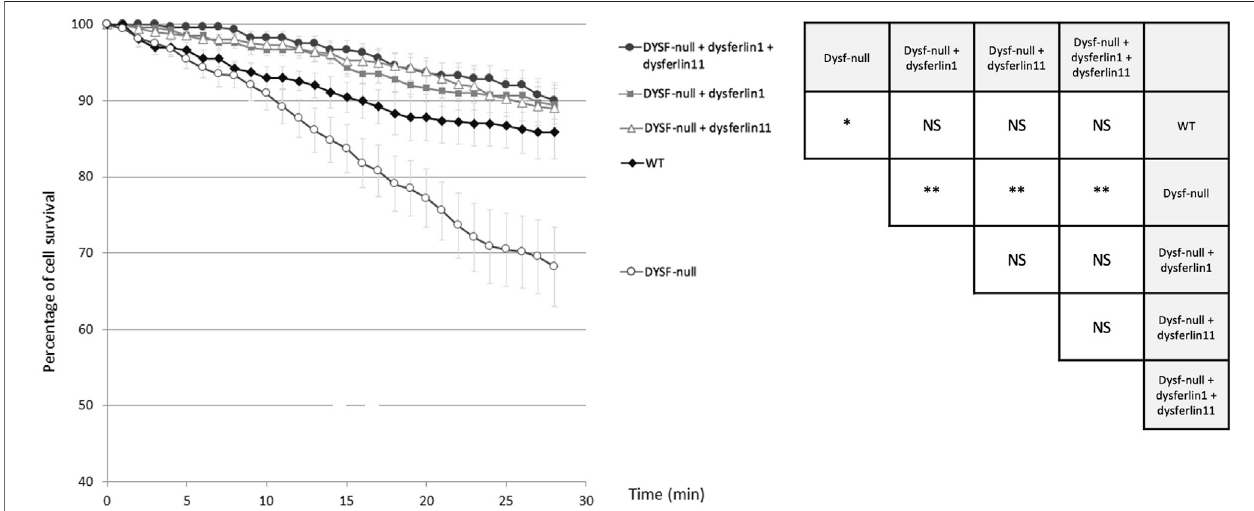
FIGURE4| Dysferlin 11transcriptparticipatesin theprotection ofmembrane myoblasts from mechanical stress induced byosmotic shock.Osmotic shock assay performed on control human myoblasts (WT, C25), dysferlin-null human myoblasts (DYSF-null, AB320) and transfected dysferlin-null human myoblasts (DYSF-null + GFP-dysferlin1, DYSF-null+GFP-dysferlin11,DYSF-null+GFP-dysferlin1+GFP-dysferlin11)inhypotonicsolution(ultrapuredistilledwater).Fluorescenceimageswere takeneveryminutefor30 min.Mediumchangewasdoneatt (cid:2) 1 min.Alldataaremean ± SEM(Standarderrorofthemean)for n (cid:2) 10.Foreachexperiment,atleast 20 cells were observed. Statistical analysis was performed using Mann-Whitney test (NS: non-signi fi cant, *: p -value < 0.05, **: p -value < 0.01).